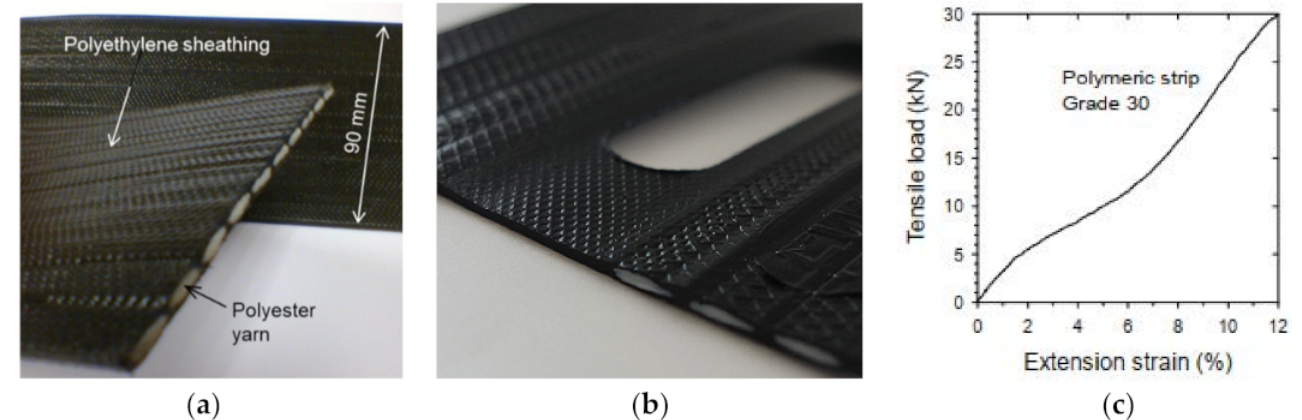
Figure 4. Polymeric strip products from GECO [20]: ( a ) FASTEN FS and ( b ) FW (perforated), and ( c ) typical load-extension behavior of grade 30 strip. (Modified from